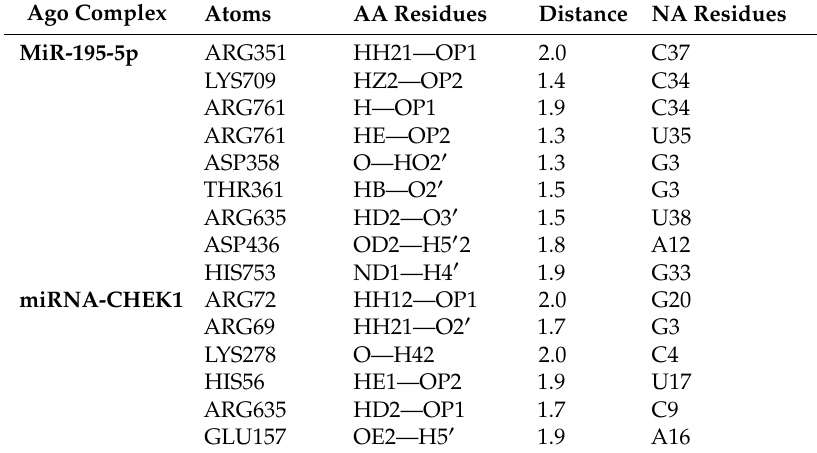
Table 6. Hydrogen bond interaction observed in the binding pocket of the human argonaute protein and miR-195-5p, andmiR-195-5p-CHEK1 within the distance of 2.0 Å. Ago Complex Atoms AA Residues